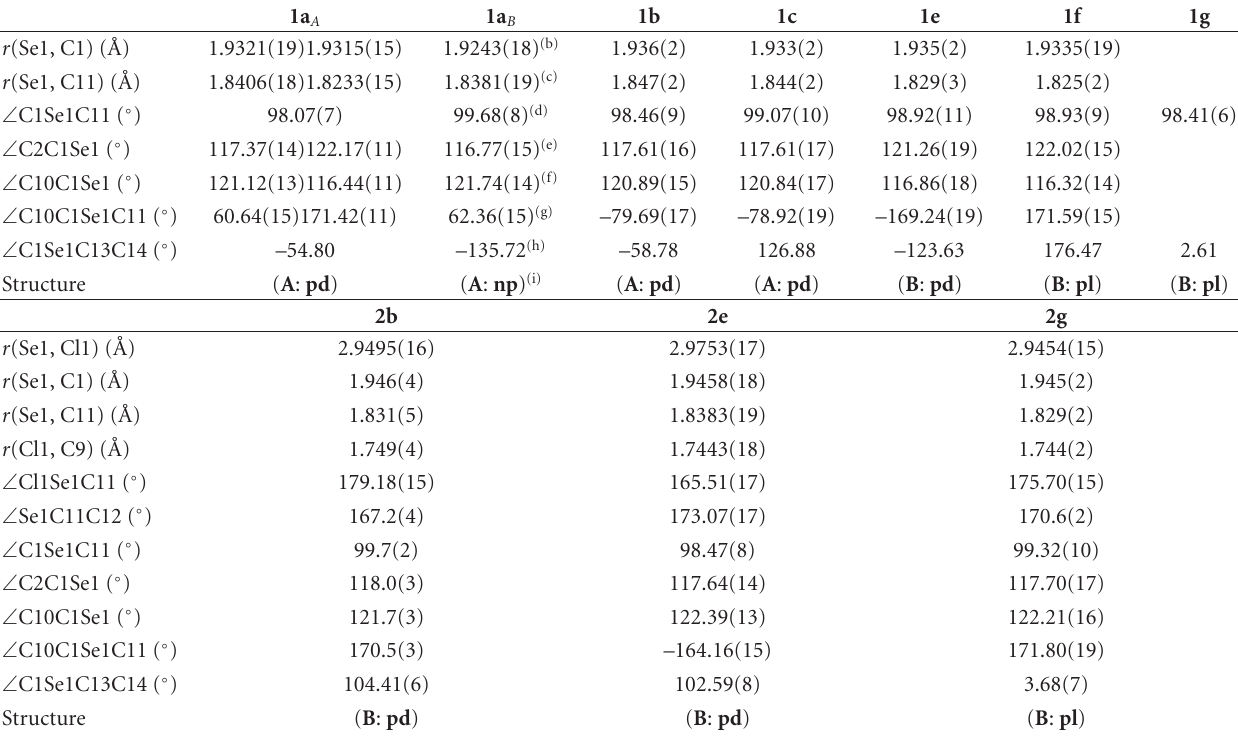
Table 1: Selected bond distances, angles, and torsional angles around Se atom, observed in 1 and 2 (a) . 1a A 1a